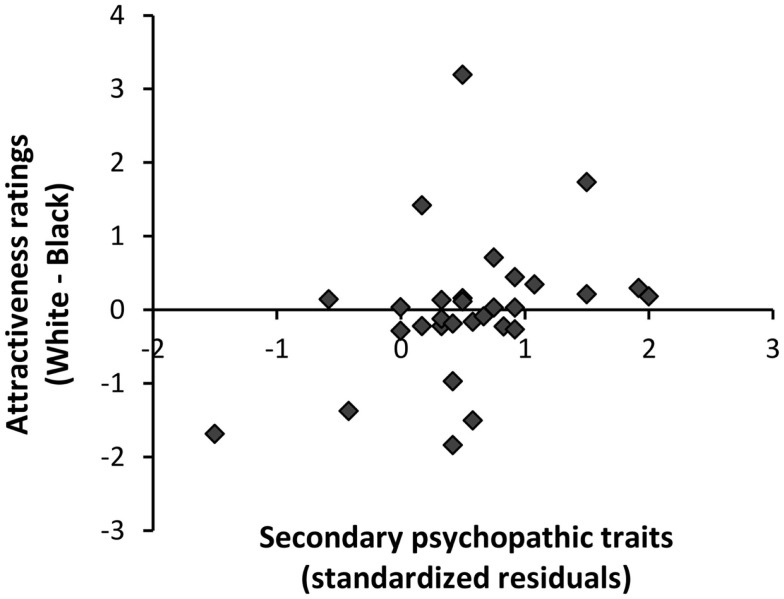
Relationship of secondary psychopathic traits with judgments of attractiveness for ethnic ingroup relative to ethnic outgroup faces. A partial correlation, controlling for primary psychopathic traits, showed that increasing secondary psychopathic traits were associated with more positive ratings of attractiveness for ethnic ingroup faces relative to ethnic outgroup faces (r = 0.38, p < 0.05).